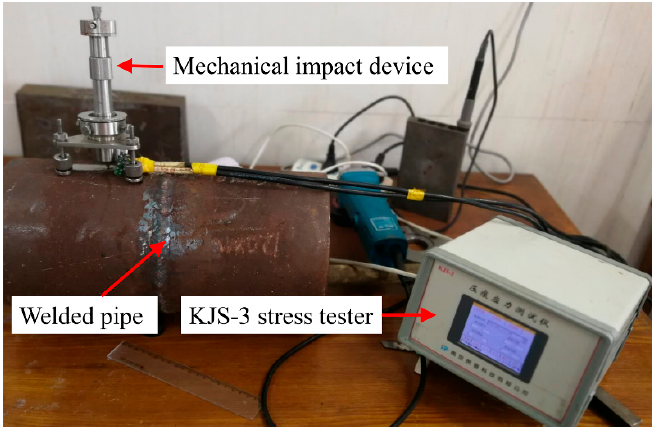
Figure 5. Residual stress measurement by instrumented indentation test.